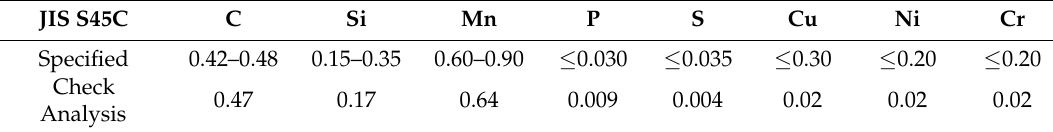
Figure 7. Comparison of relationship between normalized midplane crack-opening stress on x 1 -axis σ 22T FEA / σ 22T and load P without ( P pre = 0 kN) and with ( P pre = 54 kN) CRS for HT780. When the difference in σ 22T FEA / σ 22T between the two cases became smaller than 1%, fracture was observed for the case with CRS.